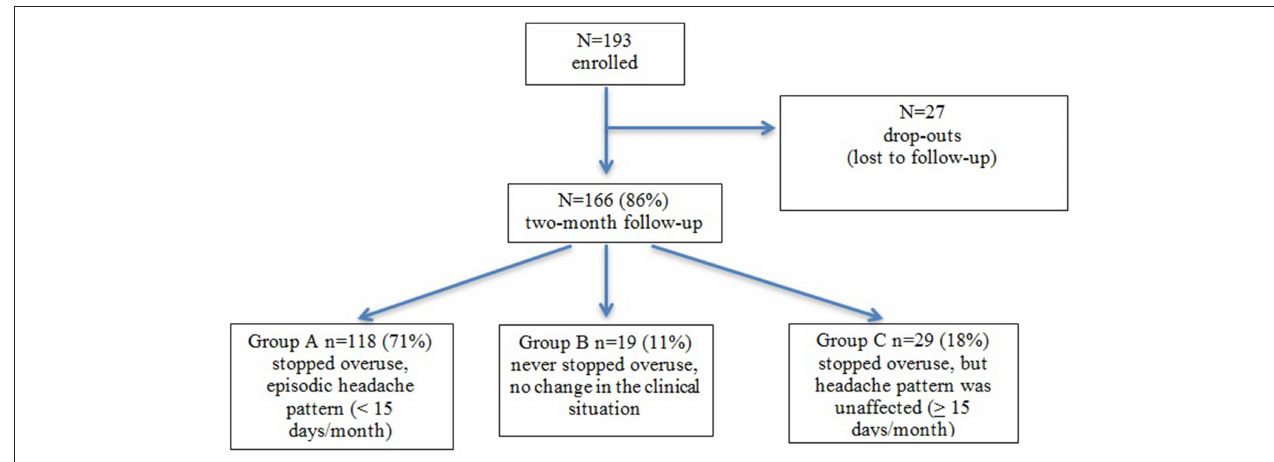
FIGURE 1 | Diagram of the study and clinical pattern at the 2-month